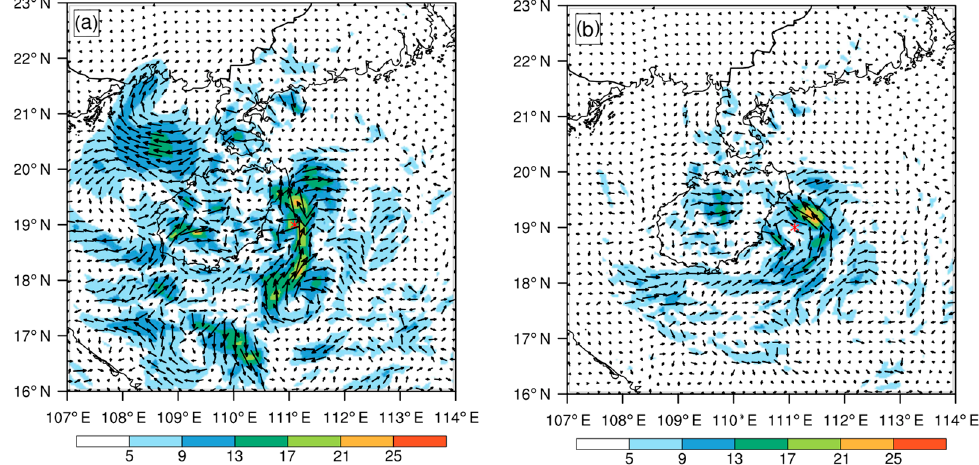
Figure 7. The increments of wind vector on 850 hPa at 0600 UTC 13 October. (( a ) DA_ ψχ ; ( b ) DA_UV). (Shaded; units: m s − 1 ). The center location of Kompasu from CMA is indicated (red